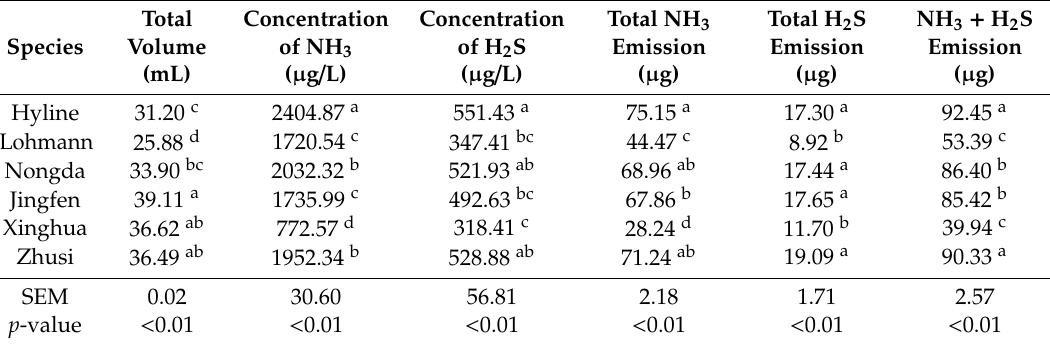
Table 1. In vitro fermentation odour production in six species of laying hens ( n =